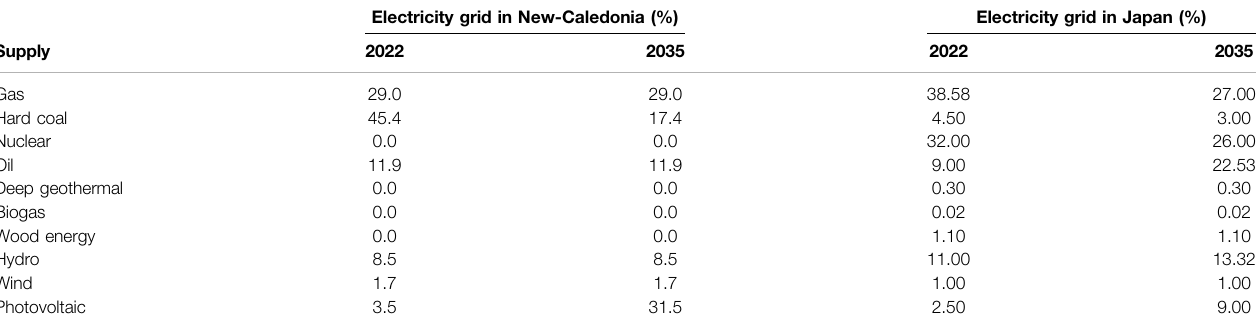
TABLE 2 | Electricity grid supply assumptions for New-Caledonia and Japan at the two production time-horizons (2022 and